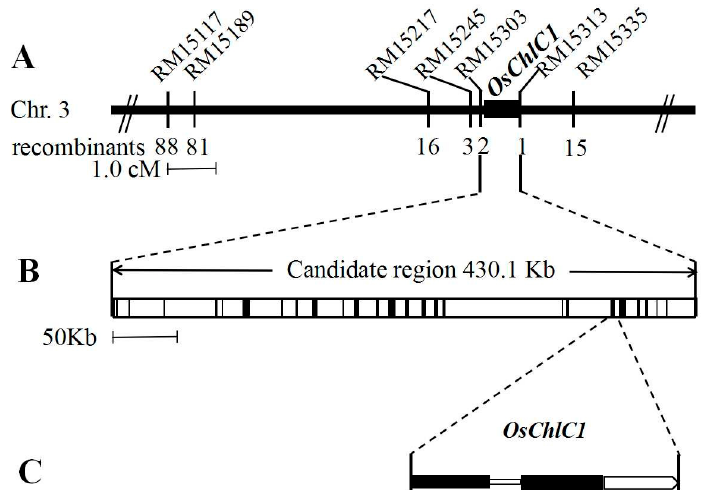
Figure 7. Molecular mapping of the ygl9311 locus. ( A ) OsChlC1 was narrowed between SSR markers RM15303 and RM15313 basing on analysis of 1325 recessive F 2 plants. ( B ) Total of 2 differentially expressed genes were found in the region between RM15303 and RM15313. ( C ) Candidate gene OsChlC1 comprises two exons and one intron.